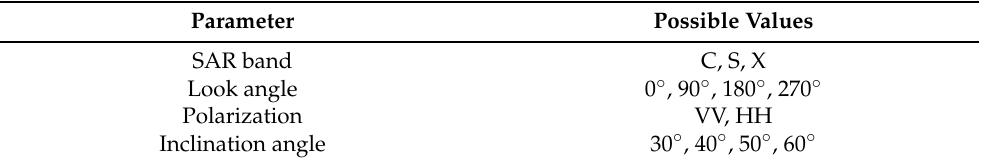
Table 1. Run matrix for SAR image generation from [17]. The look angle is the azimuth angle between the radar direction and the ship direction, and the inclination angle is the angle between the vertical axis and the direction from the radar to the ship wake